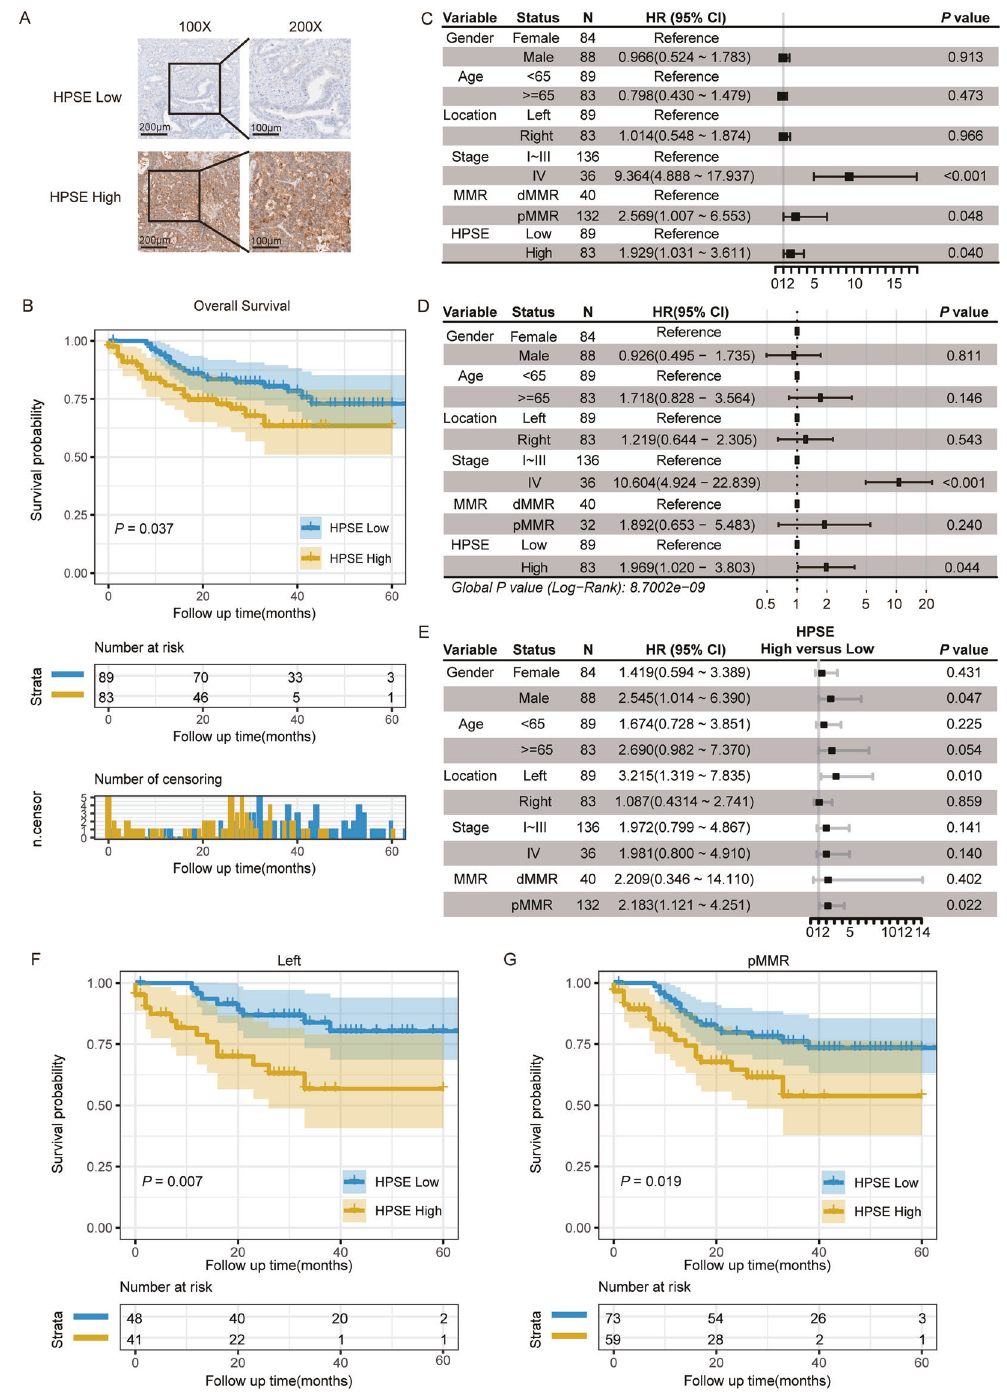
Fig. 2 High HPSE expression level is associated with poor prognosis of BRAF V600E-mutant CRC patients. A Representative images of immunohistochemical staining for HPSE. B Kaplan – Meier survival curves in HPSE high and low groups of patients with BRAF V600E-mutant CRC. A log-rank test was used to calculate the P -value. Shaded regions around the curves indicate 95% con fi dence intervals. The number of patients at risk and censoring are presented below the survival curve. C Results of univariate Cox proportional hazard model presented as Hazard ratios (blocks in the center) and 95% con fi dence intervals (Whiskers of error bars). D Results of multivariate Cox proportional hazard model presented as Hazard ratios (blocks in the center) and 95% con fi dence intervals (Whiskers of error bars). E Results of survival analysis in different subgroups. Hazard ratios (blocks in the center) and 95% con fi dence intervals (Whiskers of error bars) were determined by univariate Cox regression. The reference level in each subgroup was HPSE low. Kaplan – Meier survival curves in the ( F ) left location subgroup and ( G ) pMMR subgroup. A log-rank test was used to determine P -value. Shaded regions around the curves indicate 95% con fi dence intervals. The number of patients at risk are presented below the survival curve. R survival package, survminer package, and forest package were used for survival analysis. HR hazard ratios; CI con fi dence